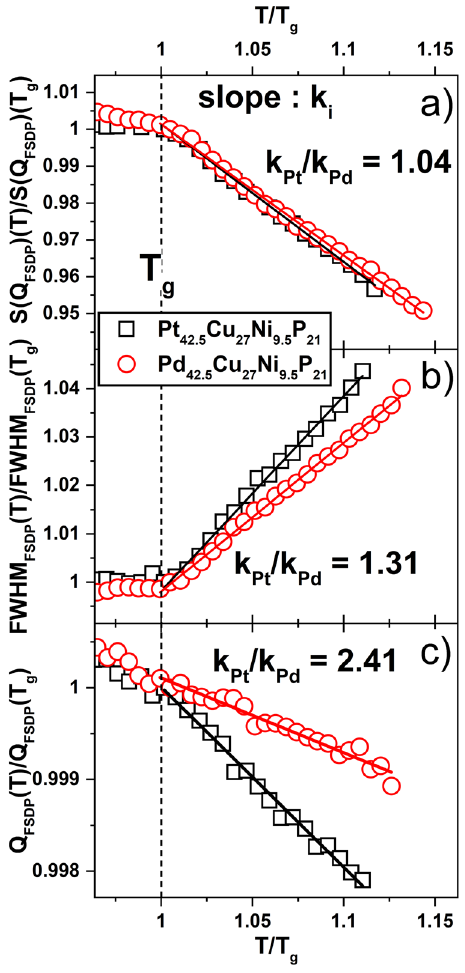
Fig. 2 Temperature dependence of the fi rst sharp diffraction peak of Pt 42.5 Cu 27 Ni 9.5 P 21 and Pd 42.5 Cu 27 Ni 9.5 P 21 measured with synchrotron X-ray diffraction. Peak intensity of the total structure factor S(Q FSDP ) ( a ), full width at half maximum FWHM FSDP ( b ) and peak position (Q FSDP ) ( c ) of the fi rst sharp diffraction peak as a function of temperature normalized by the glass transition temperature T/T g for the Pt-based (black squares) and Pd-based (red circles) alloys. All data are normalized to the respective value of the glass transition. In all panels, k is the respective slope of a linear fi t of the data in the liquid state of the Pt/Pd-based alloys (above the glass transition temperature T g